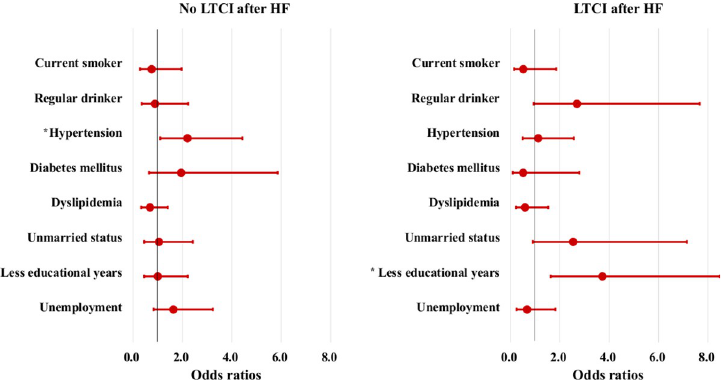
Fig 3. Odds ratios (95% confidence interval) for having each risk factor in the no long-term care insurance after heart failure and long-term care insurance after heart failure groups. Error bars represent the 95% confidence intervals. Adjustment for smoking, drinking, hypertension, diabetes mellitus, dyslipidemia, unmarried status, lower educational level ( < 7 years), and unemployed status using conditional logistic regression analysis. LTCI = long-term care insurance, HF = heart failure. � Statistically significant (P <